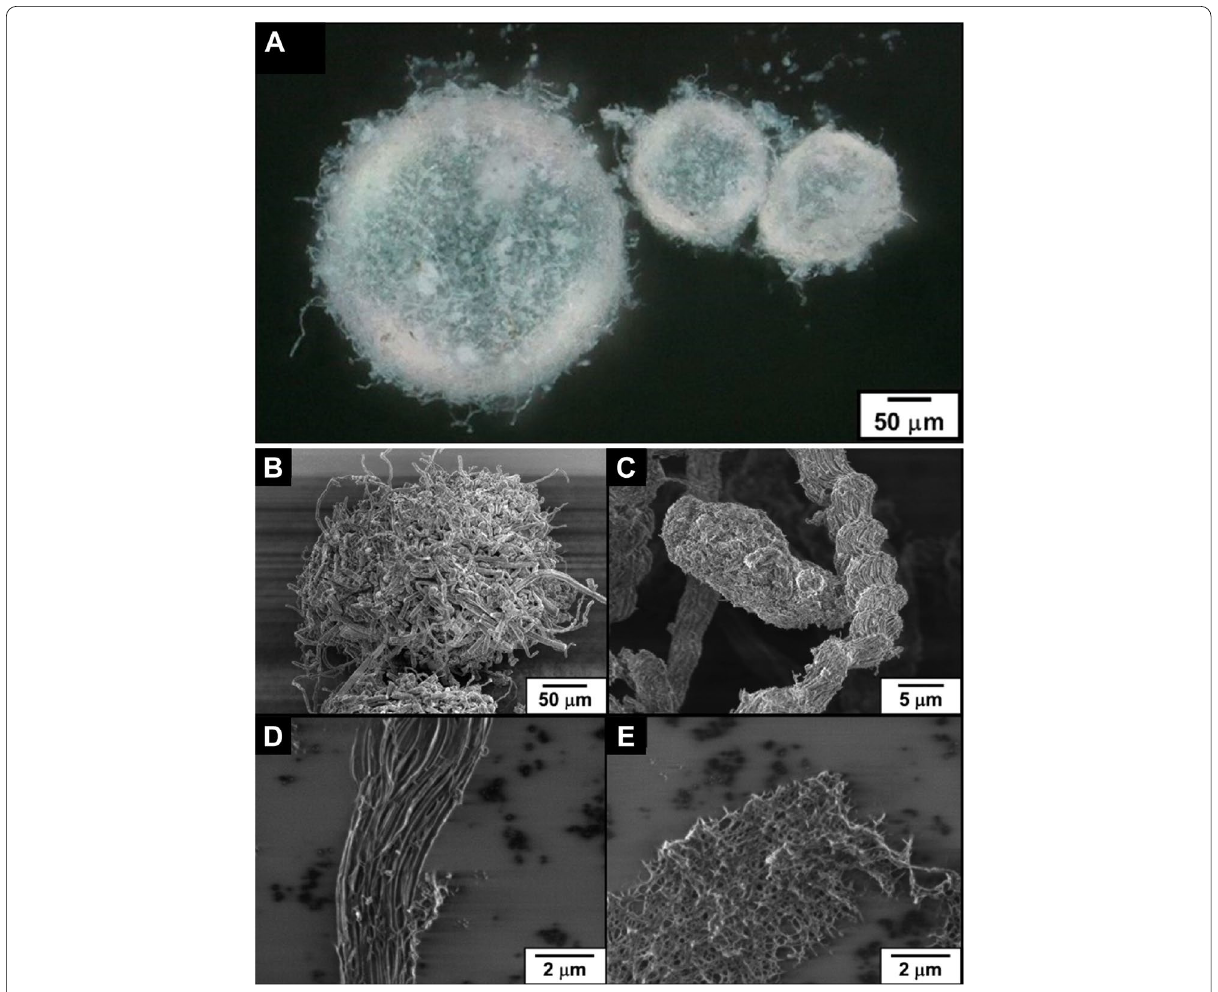
Fig. 8 Liquid marbles (LMs). A Stereomicroscopy image of LMs fabricated by the gall-forming aphid Eriosoma moriokense . B – E FESEM images of the LMs treated with the NanoSuit method. From Kasahara et al. 2019 with permission from the publisher